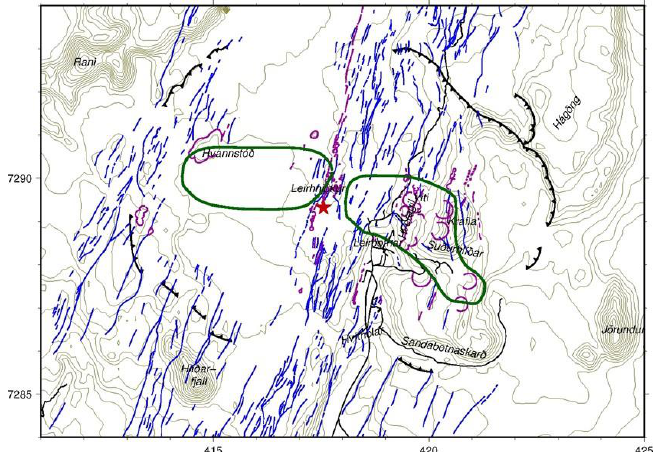
Figure 6. The location of S-wave “shadows” observed during the Krafla Fires (green). The red star shows approximate centre of uplift and subsidence [18]. Blue lines are faults and fissures and purple lines are craters and eruptive fissures. Coordinates are UTM, WGS84, zone 28 in km. A study of seismic wave propagation from earthquakes during the Krafla Fires [22] revealed volumes within the caldera where seismic S-waves were highly attenuated or could not pass through. The estimated areal extent of these S-wave “shadows” is shown in Figure 6. The upper boundaries of the shadows were estimated to be at about 3 km depth and the lower boundaries, though poorly constrained, at about 7 km depth. These volumes have been interpreted to contain magma. This will be further discussed below.